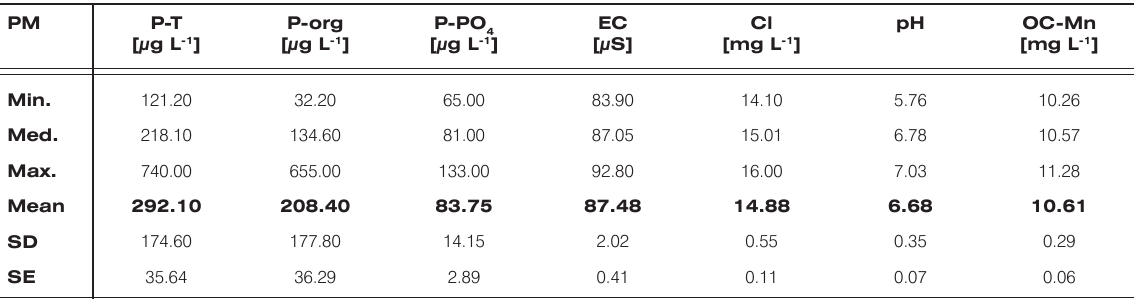
Table 2. Content of seclected forms of phosphorus, chloride ions, conductivity, oxygen consumption (Mn) and pH in surface microlayer taken by glass plate. PM